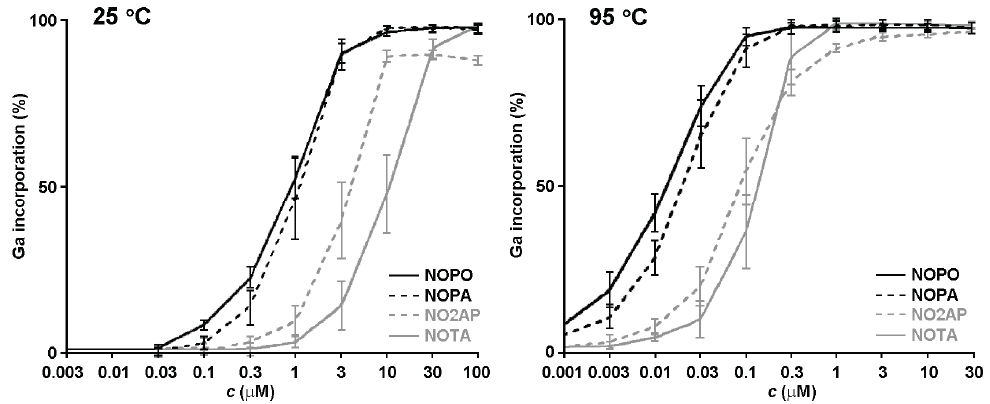
Figure 4. Labelling efficiency of the discussed chelators at 25 and 95  C at different chelator concentrations (pH = 3, n = 3).